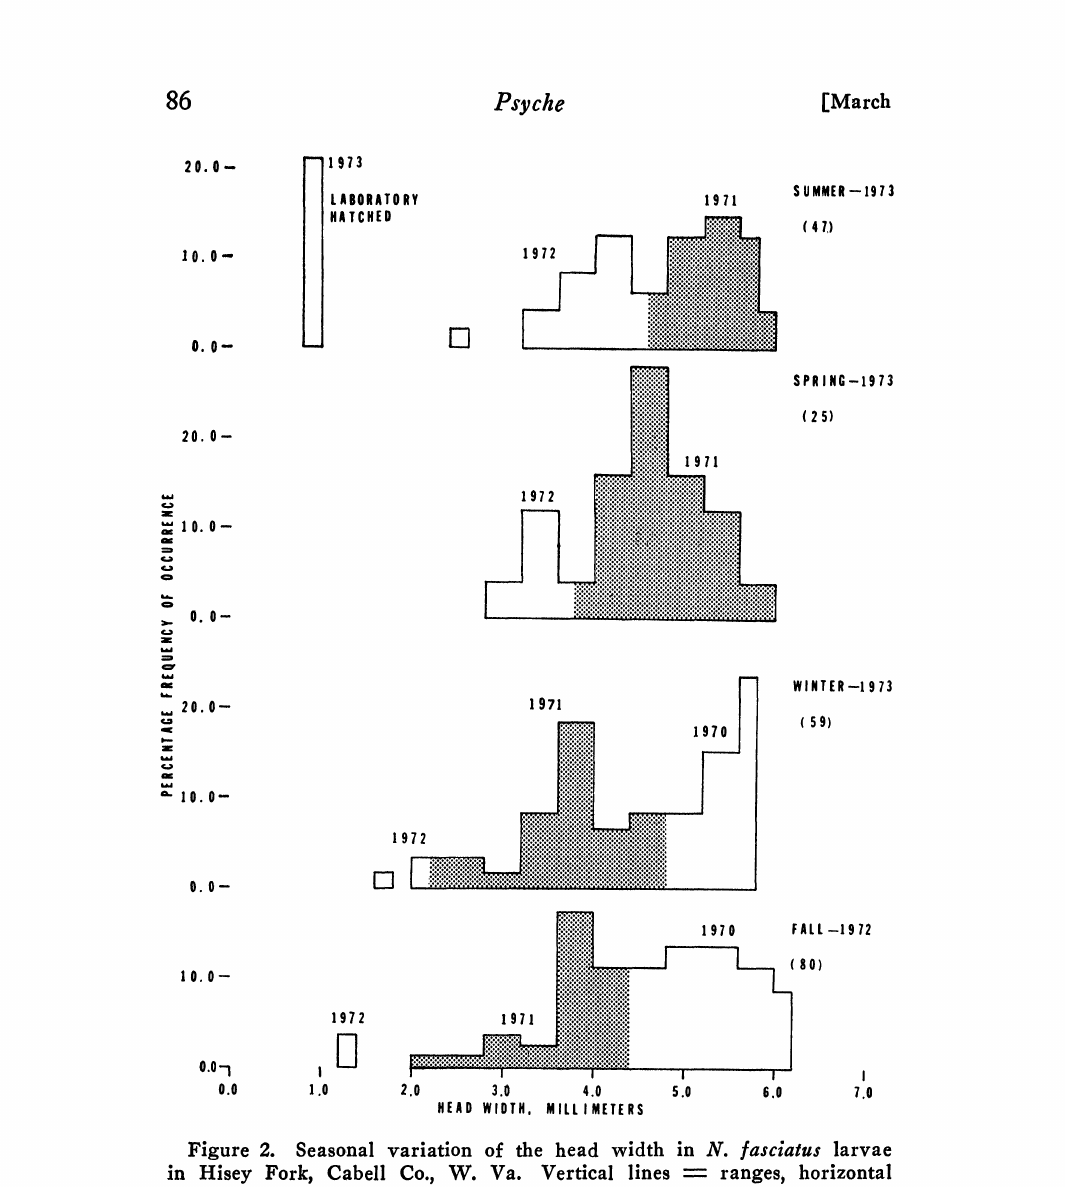
Figure 2. Seasonal variation of the head width in N. fasciatus larvae in Hisey Fork, Cabell Co., W. Va. Vertical lines ranges, horizontal lines